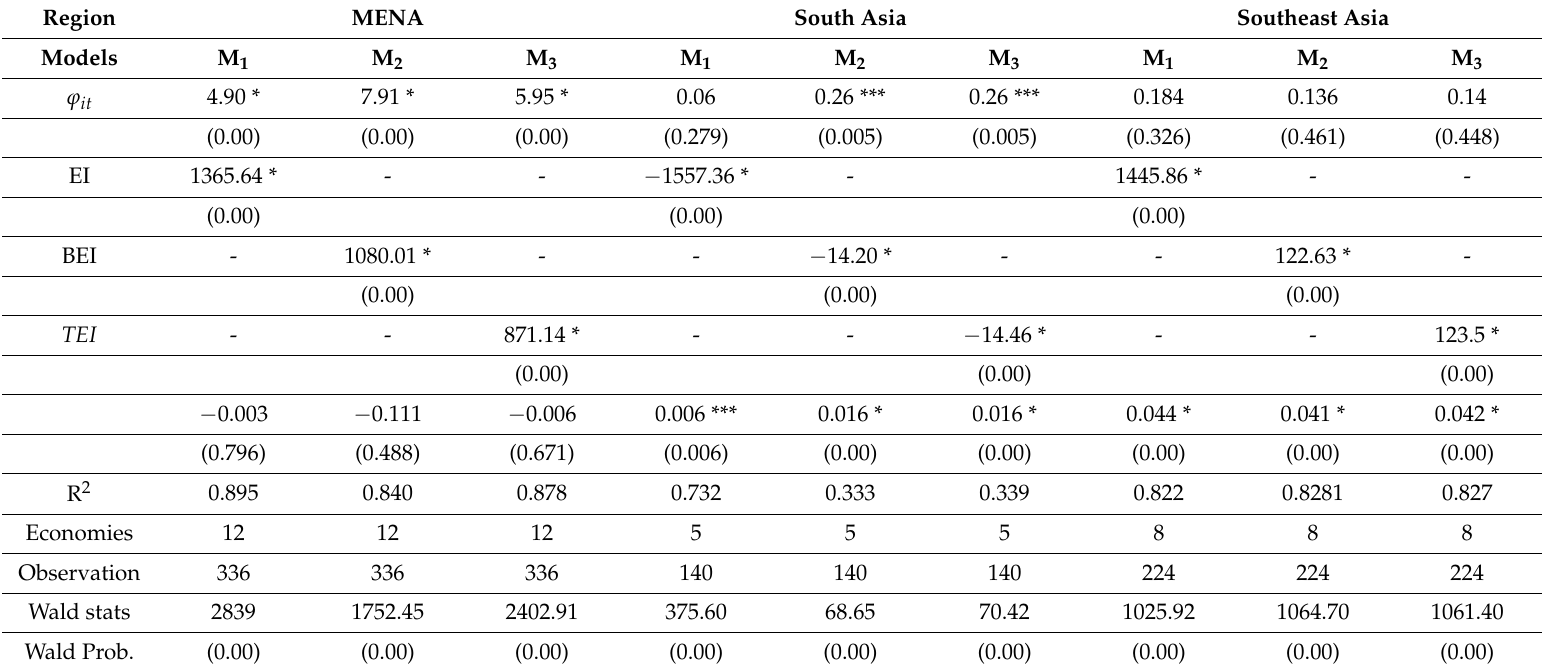
Table 6. Results of BRI Energy